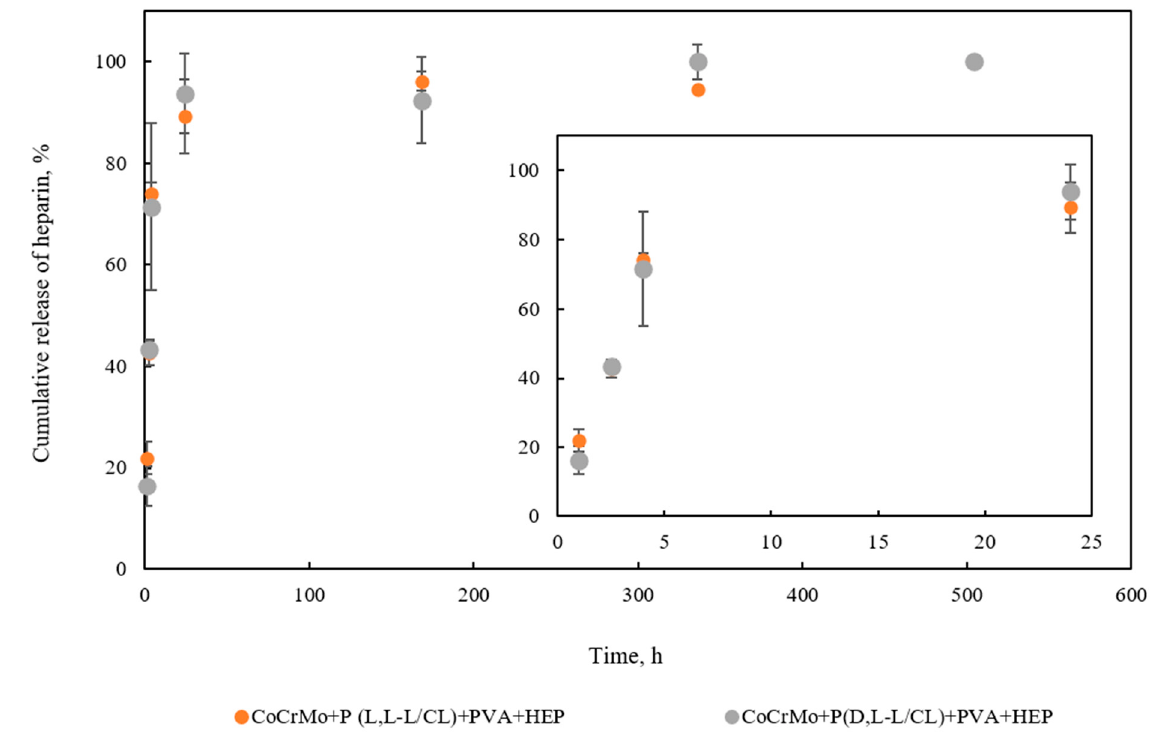
Figure 11. In vitro cumulative heparin release from polymer coatings over 504 h.